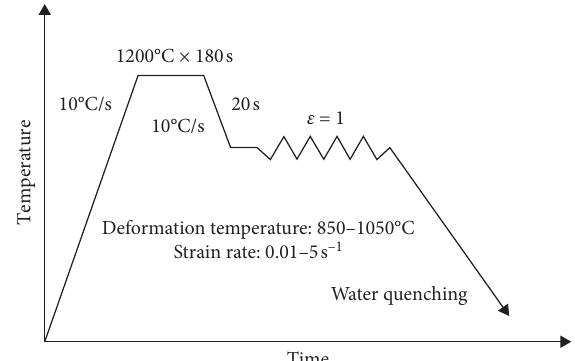
Figure 1: Schematic illustration of single-pass compression